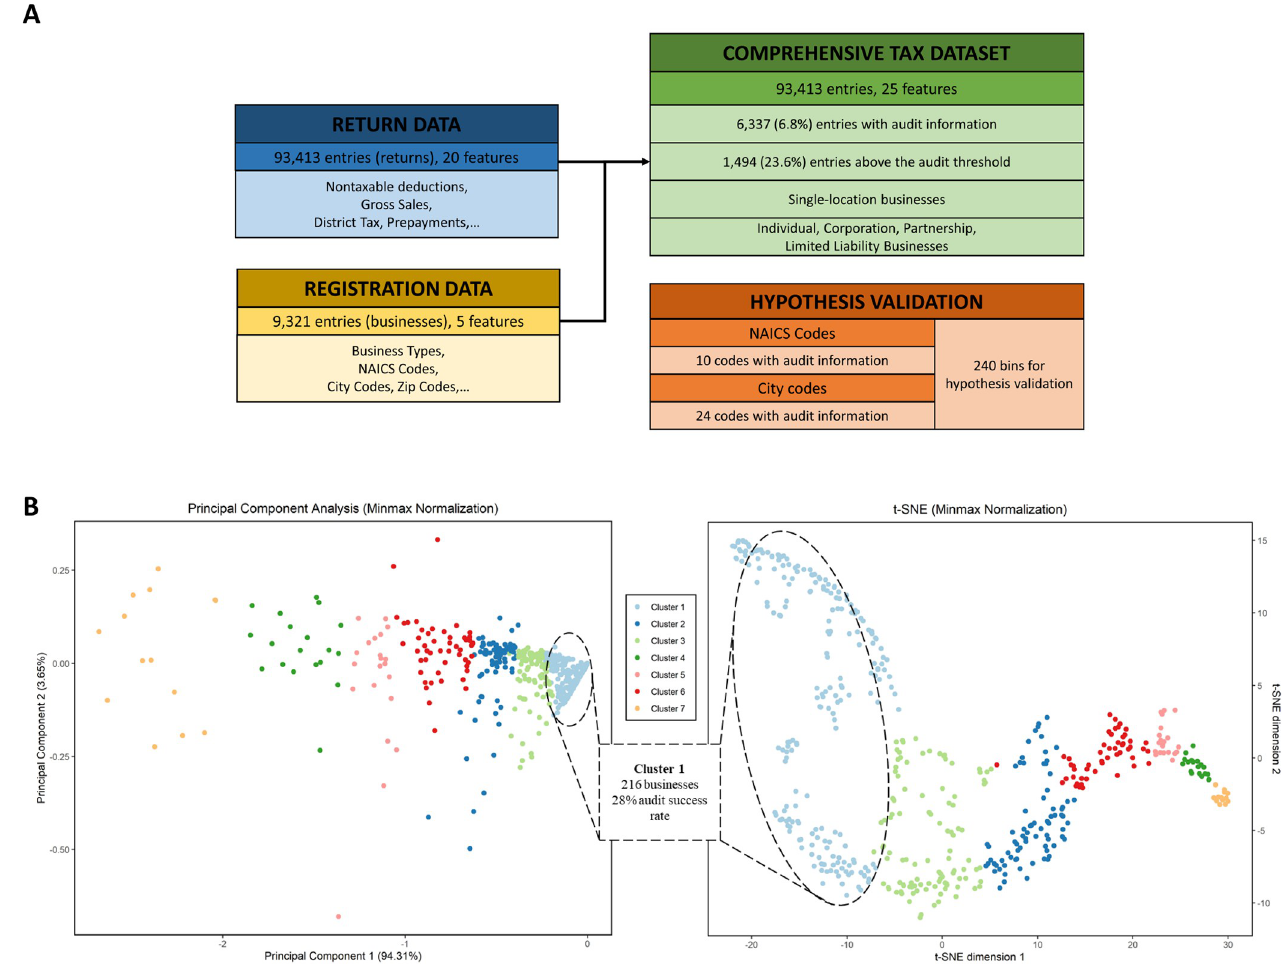
Fig 2. (A) Tables showing organization of the dataset, with (B) PCA and t-SNE visualization of data with minmax normalization post-filtration. K-means clustering is shown and was conducted on the PCA-data. Outliers are removed, and only datapoints with audit yield greater than $0 are shown for visualization